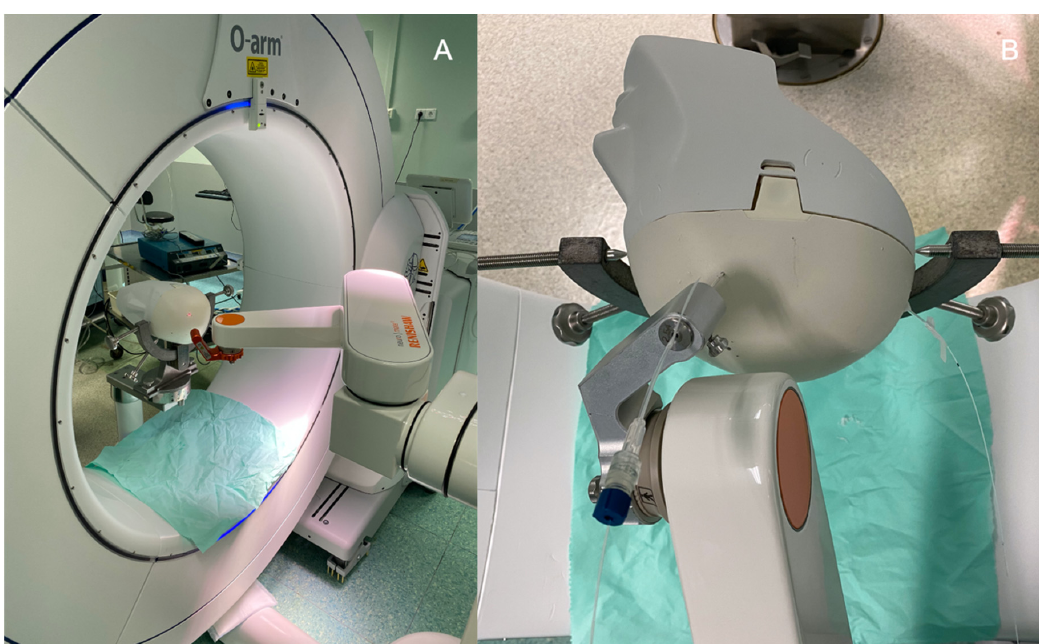
Figure 4. The brain phantom is fixed in the rigid head holder. ( A ) A rigid fiducial is fixed on the bone. Then, an ultrasound registration is performed. ( B ) The registration was performed without any bone anchored fiducial, using the neurolocate TM module adapted on the robotic arm.